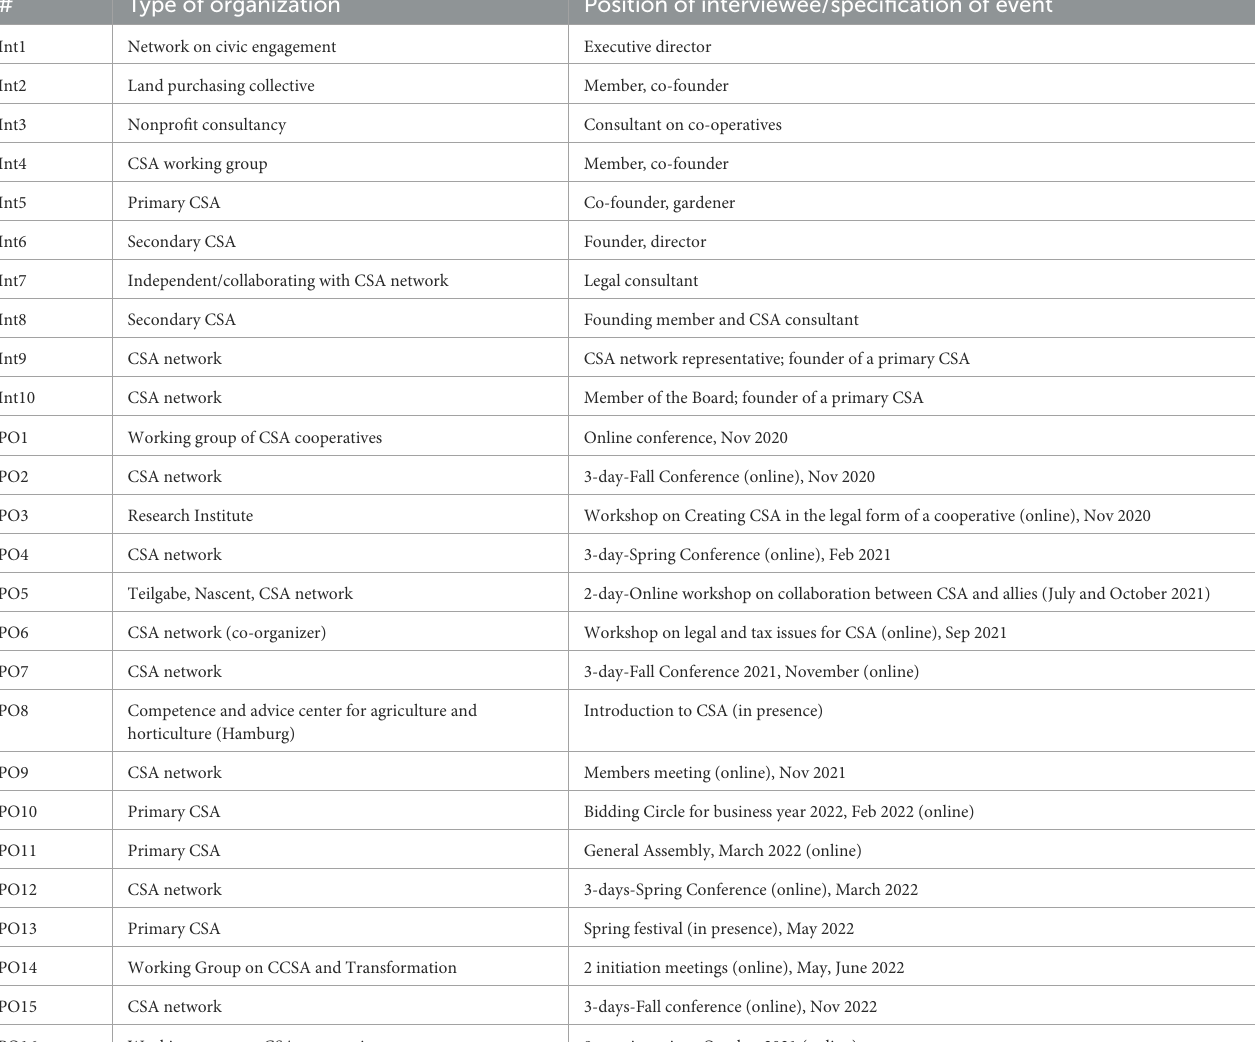
TABLE 1 List of interviews (Int) and participatory observations